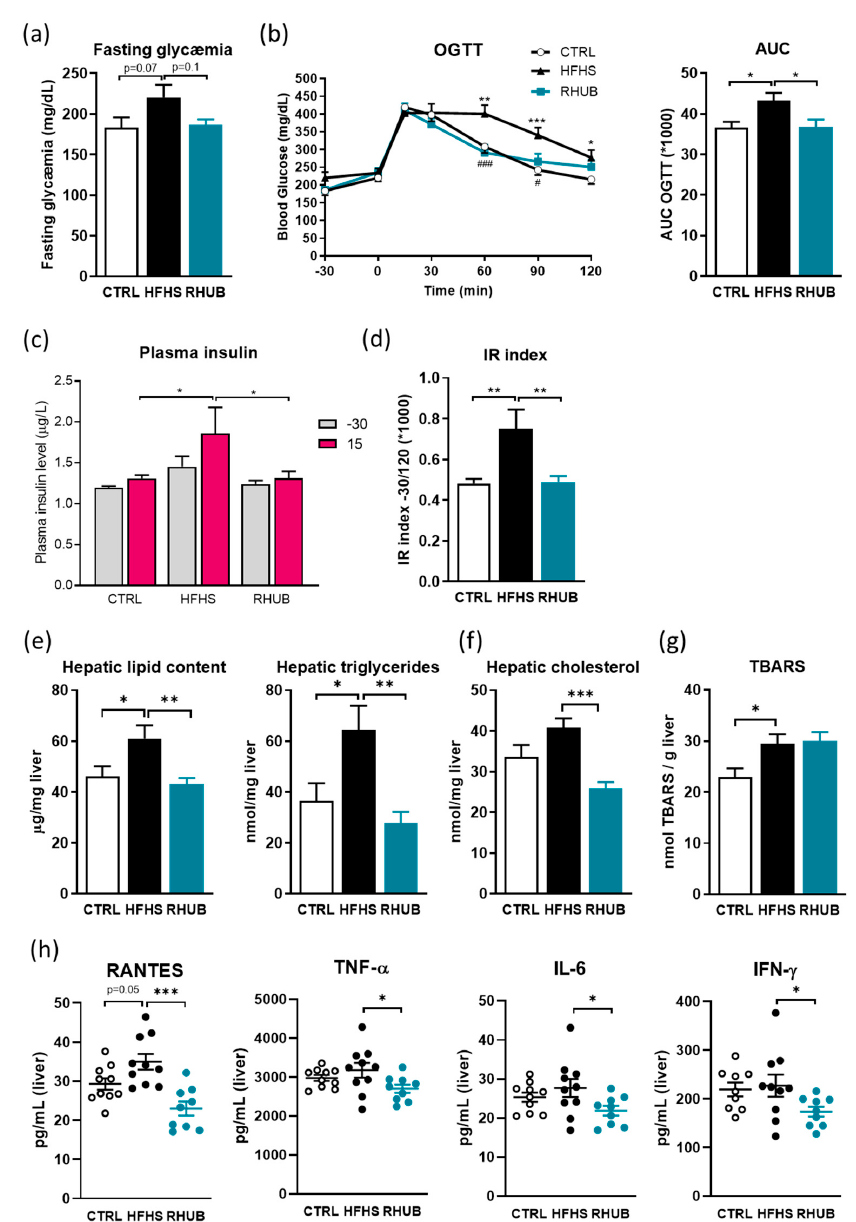
Figure 2. Rhubarb root extract blunts glucose intolerance, hepatic steatosis and liver inflammation ( a ) Plasmatic glucose (mg/dL) measured 6 h after a fasting period. ( b ) Plasma glucose profile (mg/dL) measured between 30min before and 120 min after glucose loading ( n = 8–10/group) and corresponding area under the curve. ( c ) Plasma insulin levels (µg l − 1) at 30 min before and 15 min after glucose loading. ( d ) Insulin resistance index determined by multiplying the AUC of blood glucose by the AUC of insulin. ( e ) Hepatic lipid content (µg lipids/mg liver) and hepatic triglycerides (nmol/mg liver) measured by Folch. ( f ) Hepatic cholesterol (nmol/mg liver) measured by Folch. ( g ) Thiobarbituric acid reactive substances (TBARS) in the liver. ( h ) Hepatic inflammation markers measured using Bioplex. White, CTRL fed mice; Black, HFHS fed mice and Blue, HFHS fed mice supplemented with rhubarb. Data represent mean ± SEM. * p ≤ 0.05, ** p ≤ 0.01, *** p ≤ 0.005. OGTT, Oral glucose tolerance test; AUC, Area under the curve; IR Index, Insulin resistance index; TBARS, Thiobarbituric acid reactive substances; RANTES, Regulated upon Activation, Normal T Cell Expressed and Presumably Secreted; TNF- α , Tumor necrosis factor-alpha; IL-6, Interleukin-6; IFN- γ , Interferon-gamma.